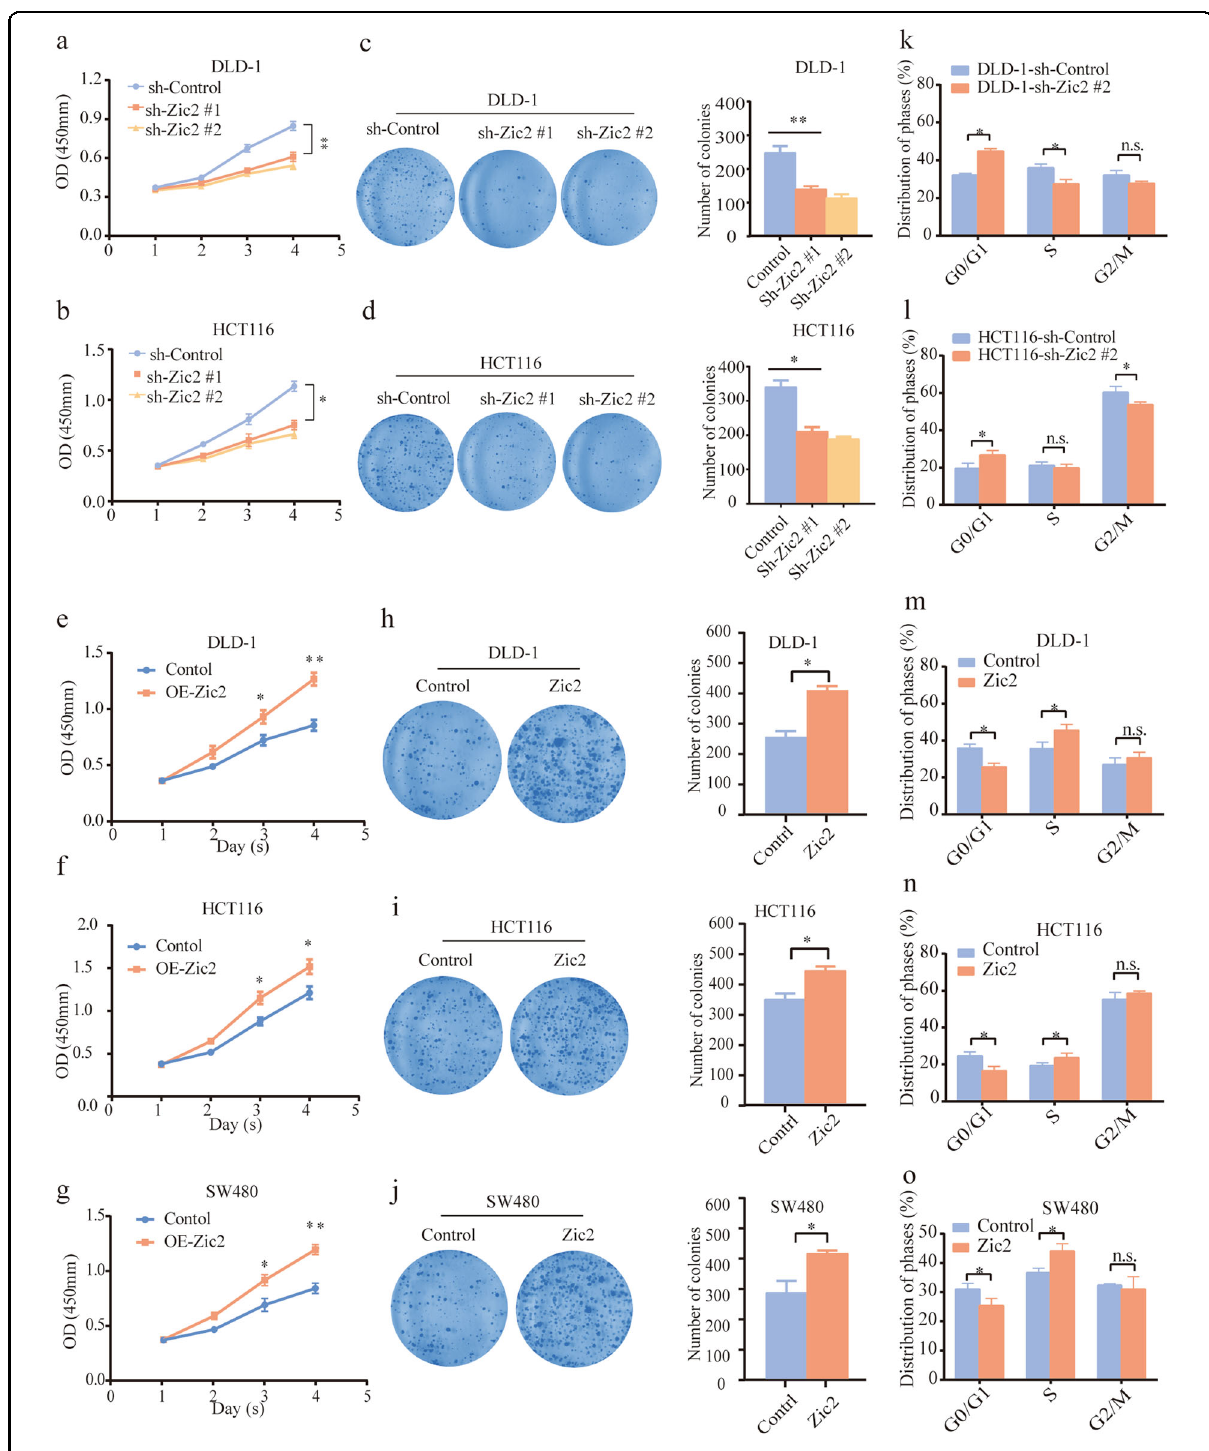
Fig. 2 Zic2 mediates colon cancer proliferation in vitro. a , b CCK8 proliferation assay in DLD-1 ( a ) or HCT116 ( b ) cells transfected with sh-Zic2 or vector. c , d Colony formation in DLD-1 ( c ) or HCT116 ( d ) cells transfected with sh-Zic2 or vector. e – g CCK8 proliferation assay in DLD-1 ( e ), HCT116 ( f ) or SW480 ( g ) cells transfected with Zic2 or vector. h – j Colony formation in DLD-1 ( e ), HCT116 ( f ) and SW480 ( g ) cells transfected with sh-Zic2 or vector. k , l Comparison of the cell cycle distribution between Zic2-knockdown cells [DLD-1 ( k ) and HCT116 ( l )] and vectors. m – o Comparison of the cell cycle distribution between Zic2-overexpressing cells [DLD-1 ( m ), HCT116 ( n ) and SW480 ( o )] and vectors. All data are presented as the mean ± SD from three independent experiments. * P < 0.05, ** P <